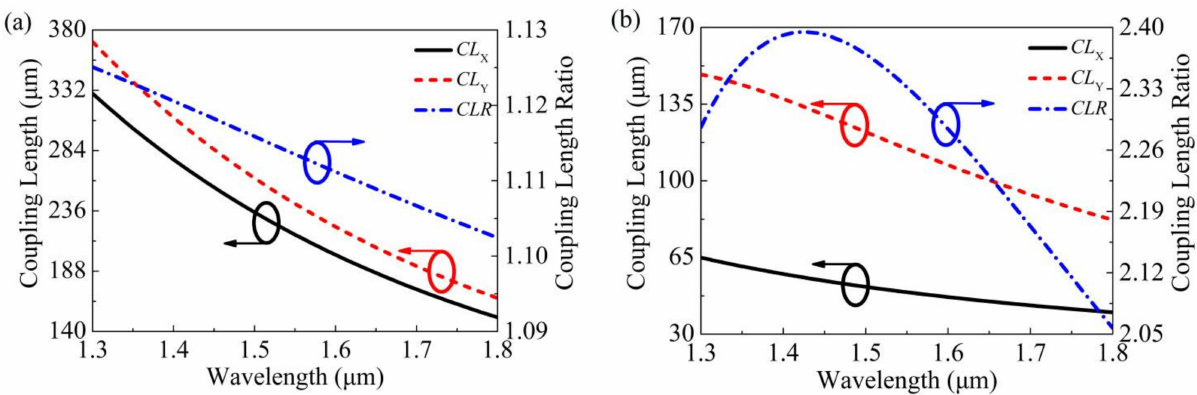
Figure 5. The CL X , CL Y , and CLR of the LC-DC-PCF when the LC-DC-PCF is filled ( a ) without and ( b ) with LC E7,